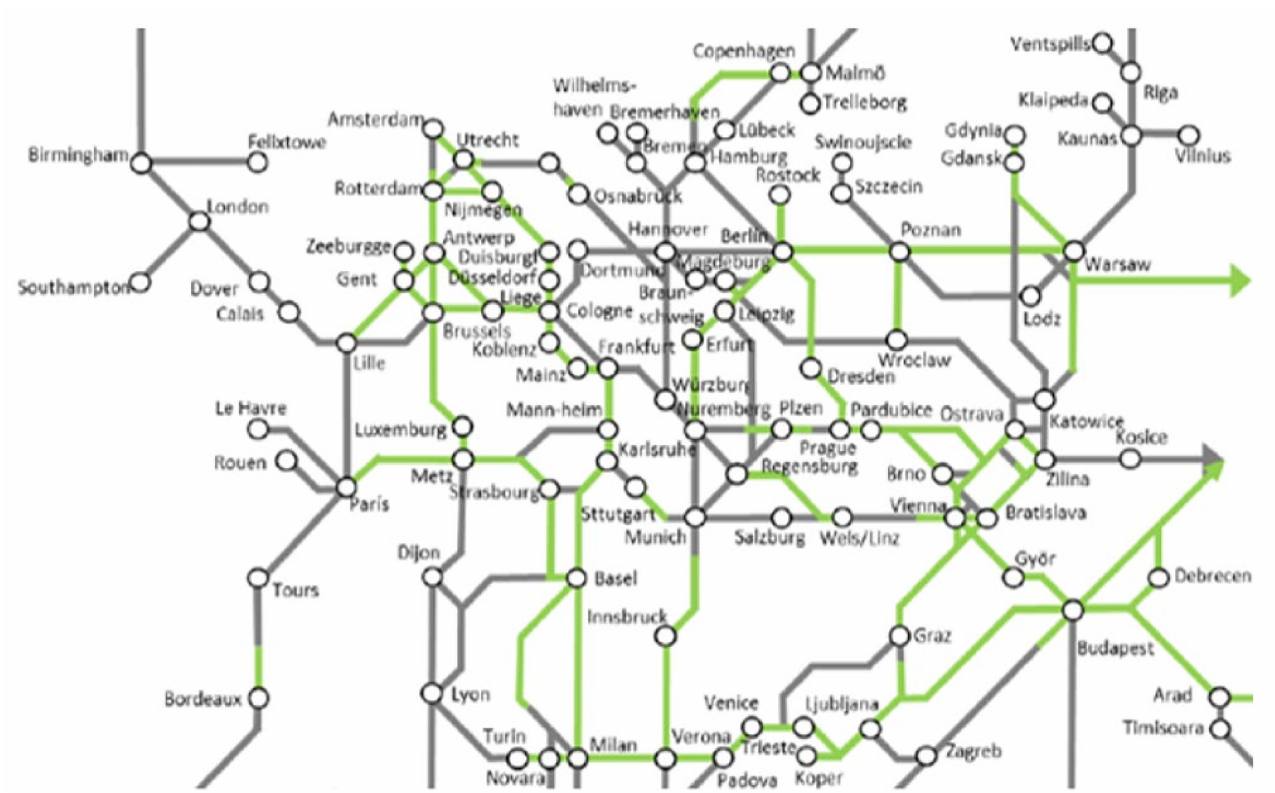
Figure 2. ETCS corridor network